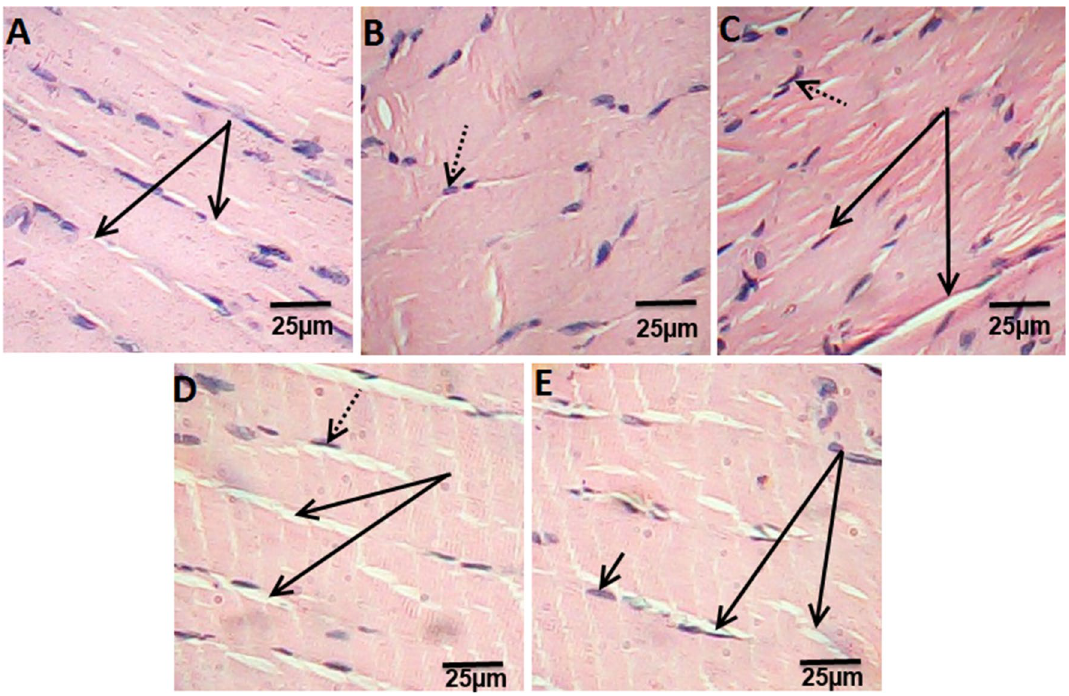
Fig. 4 Photomicrograph of hematoxylin and eosin stained muscle sections from control rats group ( a ), HFD group ( b ), ATOR group ( c ), Ech group ( d ) and ATOR + Ech group ( e ) (H&E × 400). Solid arrow: muscle fibers striation, dotted arrow: